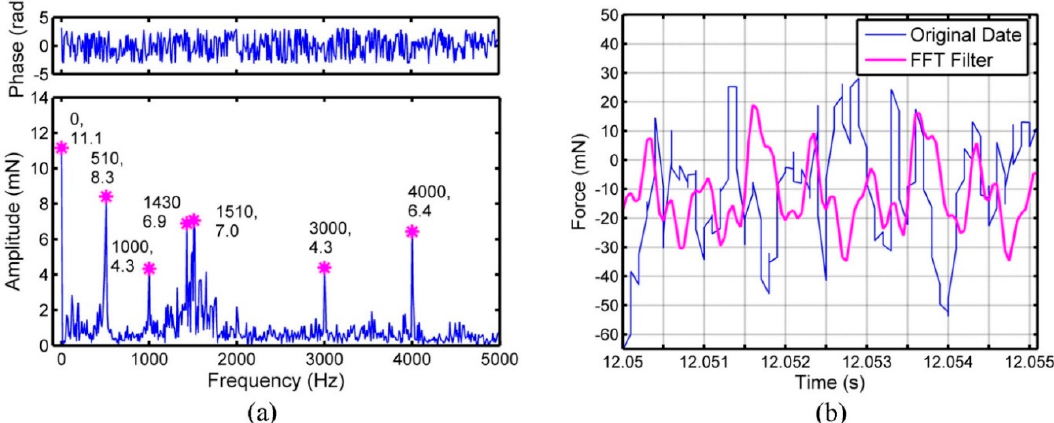
Figure 3. The cutting force signals of feed direction ( F x ): ( a ) Fast Fourier Transform (FFT) analysis on feed force, ( b ) comparative curves between original data and data after FFT filtering.